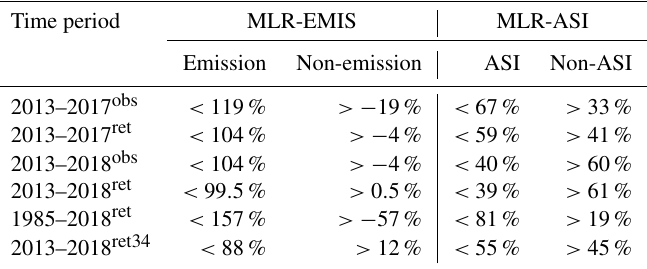
Table 7. Contributions of emissions and ASI to the PM 2 . 5 trends in